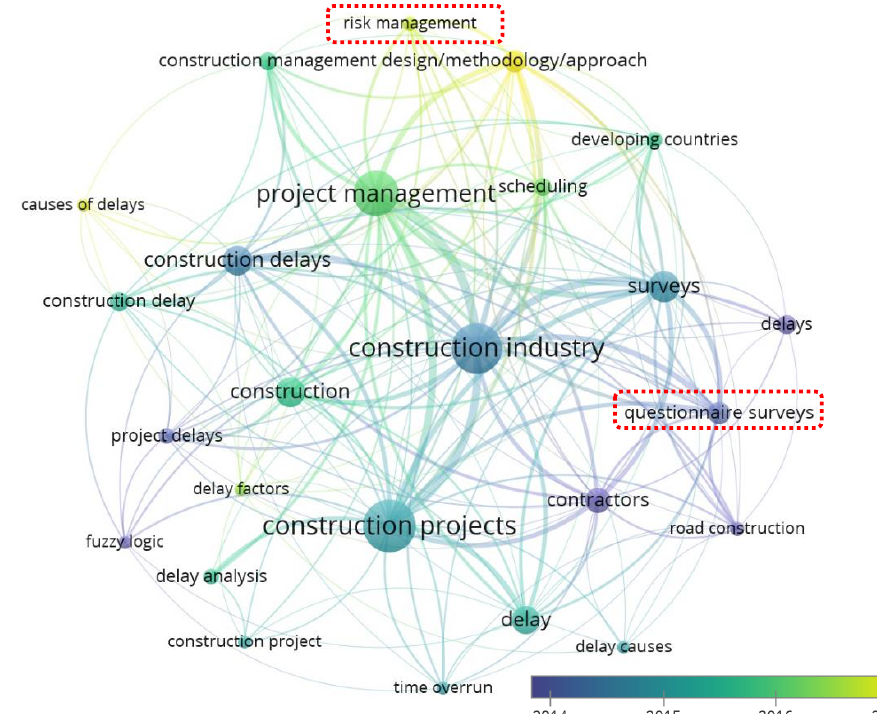
Figure 5. Co-occurrence analytical map of keywords created on the first dataset. With the minimum number of co-occurrence set as five, a total of 25 keywords out of the sample of 550 keywords are shown.